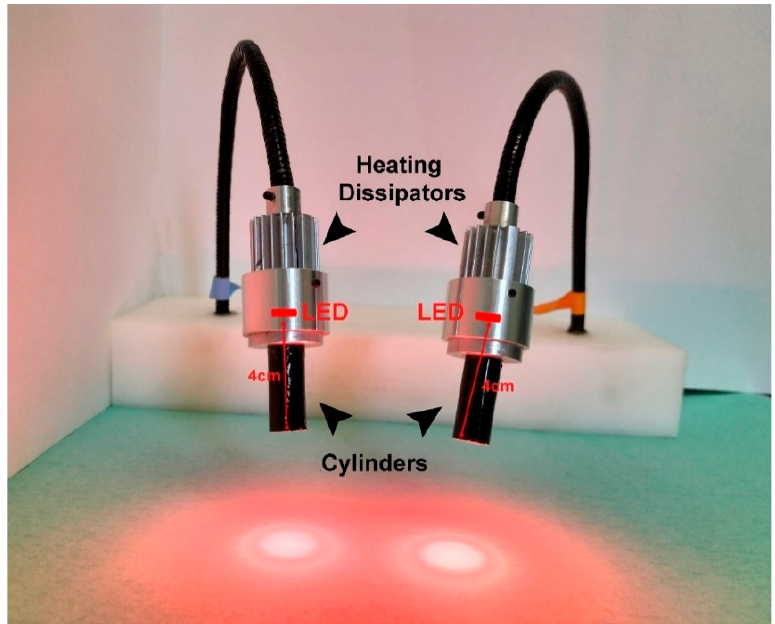
Figure 4. Device prototyped for PDT in the in vivo experimentation. Two 660 ± 2 nm wavelength LED lights were assembled on two distinct flexible arms to focus the light directly on the treated area. To converge the irradiation, two cylinders (4 cm × 1 cm) were added on top of the light source to focus the light area over the animal’s tibia, and two heat dissipators were mounted to prevent excessive thermal surcharge on the lights.